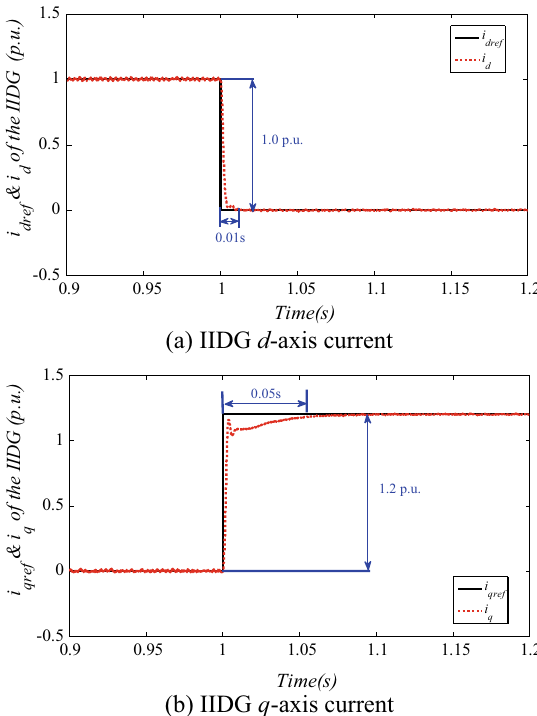
Fig. 8 Fault current characteristics of the DFIG rotor under